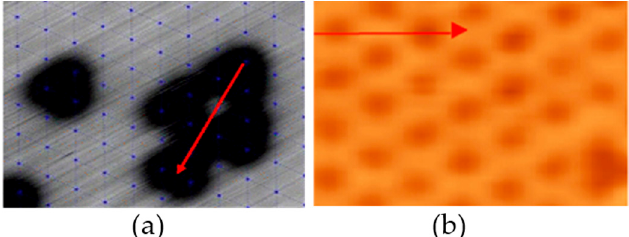
Figure 1. STM images of Pt(557) taken ( a ) under ultra-high-vacuum (UHV) conditions (8 × 10 − 11 Torr); ( b ) in 1 Torr of O 2 for 30 min and ( c ) 2 h after continuous exposure of the clean Pt(557) to O 2 gas; ( d ) after evacuating the high-performance (HP)-STM cell to 10 − 8 Torr for 1.5 h, it can be clearly seen that the clusters degenerate into distinct step edges.